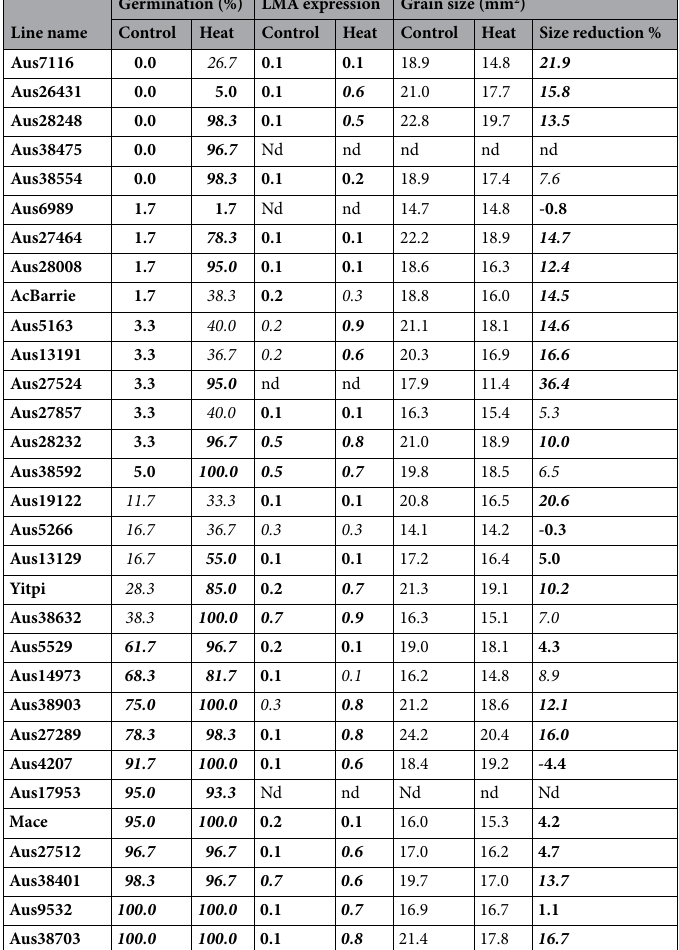
Table 2. Classification of the landraces based on Germination %, LMA expression and grain size reduction. The different genotypes were classified into three categories for each trait: bold (< 5% germination, < 0.2 LMA, or < 5% seize reduction), italic (> 5% to < 50% germination, > 0.2 to < 0.5 LMA, or > 5% to < 10% size reduction) and bold italic (> 50% germination, > 0.5 LMA, or > 10% size